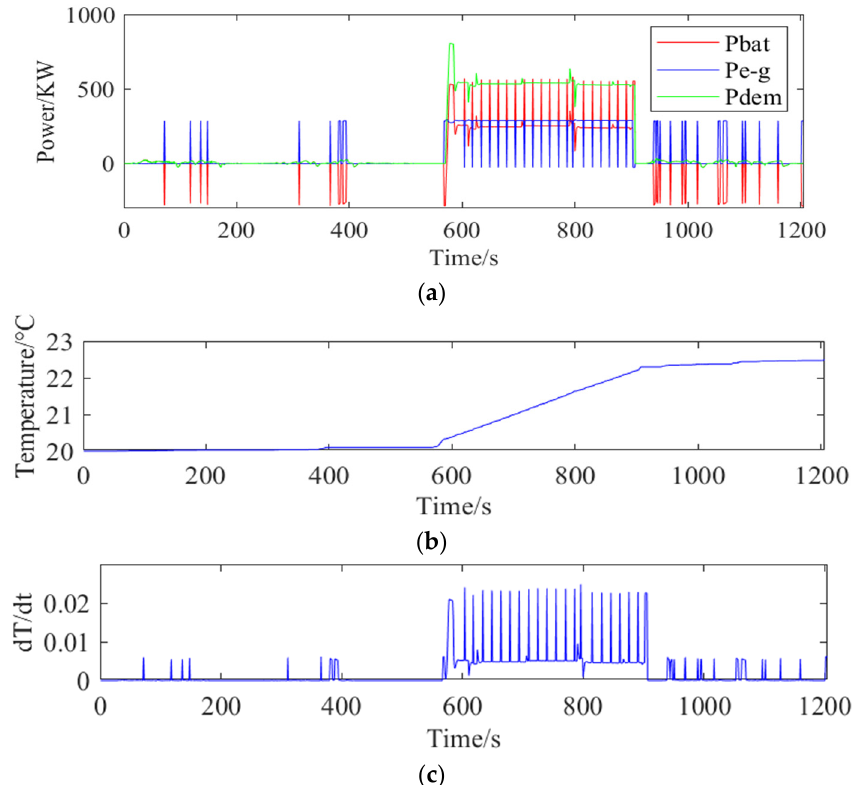
Figure 13. Validation of the PMP-MPC strategy under the air-ground driving cycle B. ( a ) The blue line represents the engine-generator set power; the red line represents the battery power; the green line represents the demand power. ( b ) Battery temperature profiles. ( c ) Battery temperature change rate per instant.